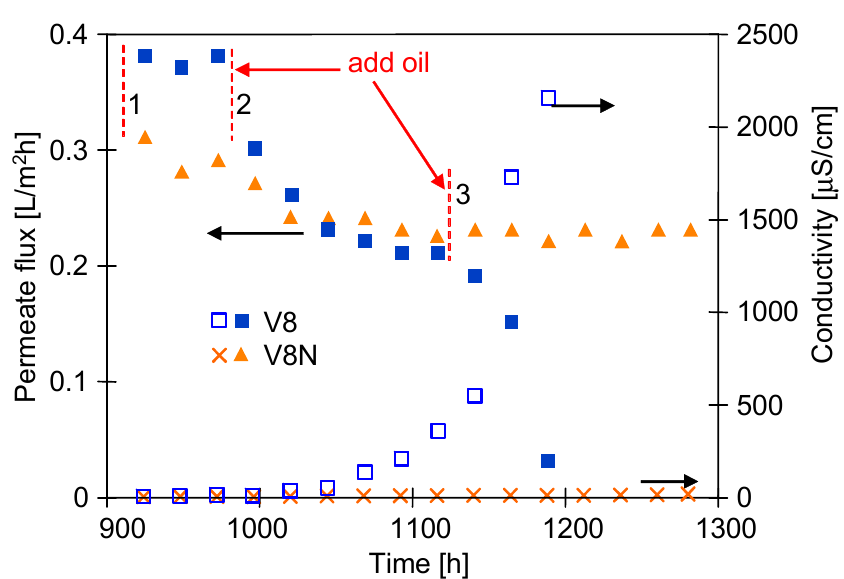
Figure 10. Changes in the permeate flux and the conductivity of the distillate during MD realized in a two-chamber MDC installation. Feed: saturated NaCl solution contaminated with oil. Temperature inside: feed tank 328 K and crystallizer 318 K. Module M5 (V8) and M6 (V8N). Oil concentration: 1—64 mg/L, 2—94 mg/L, 3—124 mg/L.